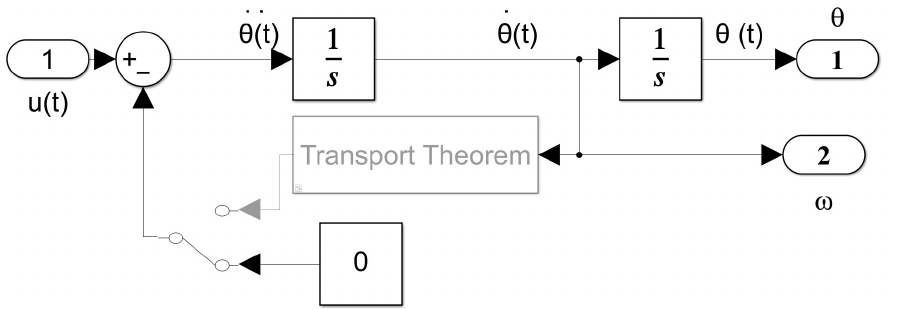
Figure A2. Addition of Gaussian noise to sensor data.